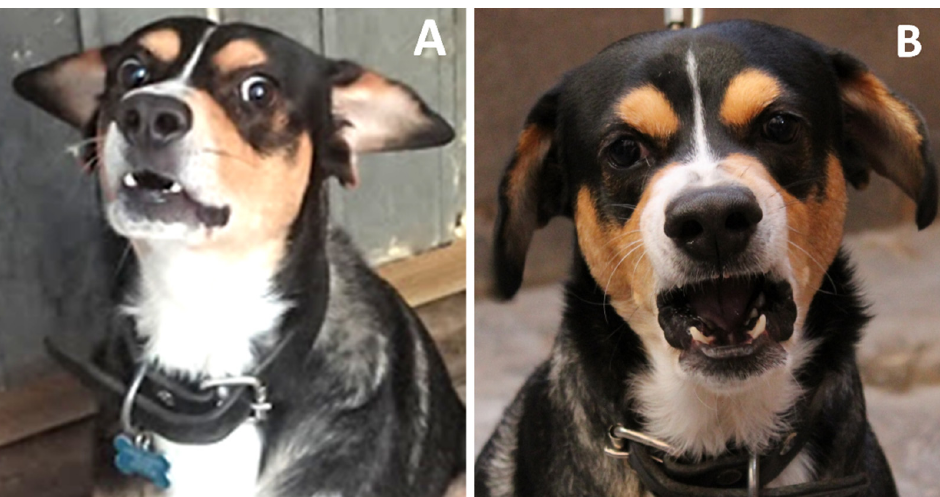
Figure 8. Facial expressions related to fear can provoke aggression. ( A ) Nose, sclera, and snout. Increased exposure of the sclera is caused by raised eyebrows and tension in the nasal region with flared nostrils, accompanied by an open mouth, raised upper lip, and exposed fangs. Additionally, dogs may emit vocalizations. ( B ) Ears and gaze. The positioning of the ears is commonly seen to be at a medium height concerning the frontal region; the animal’s gaze is fixed in the direction of the threatening stimulus.